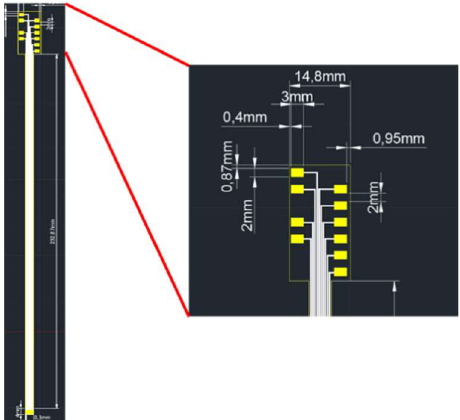
Figure 17. Flexible board design.